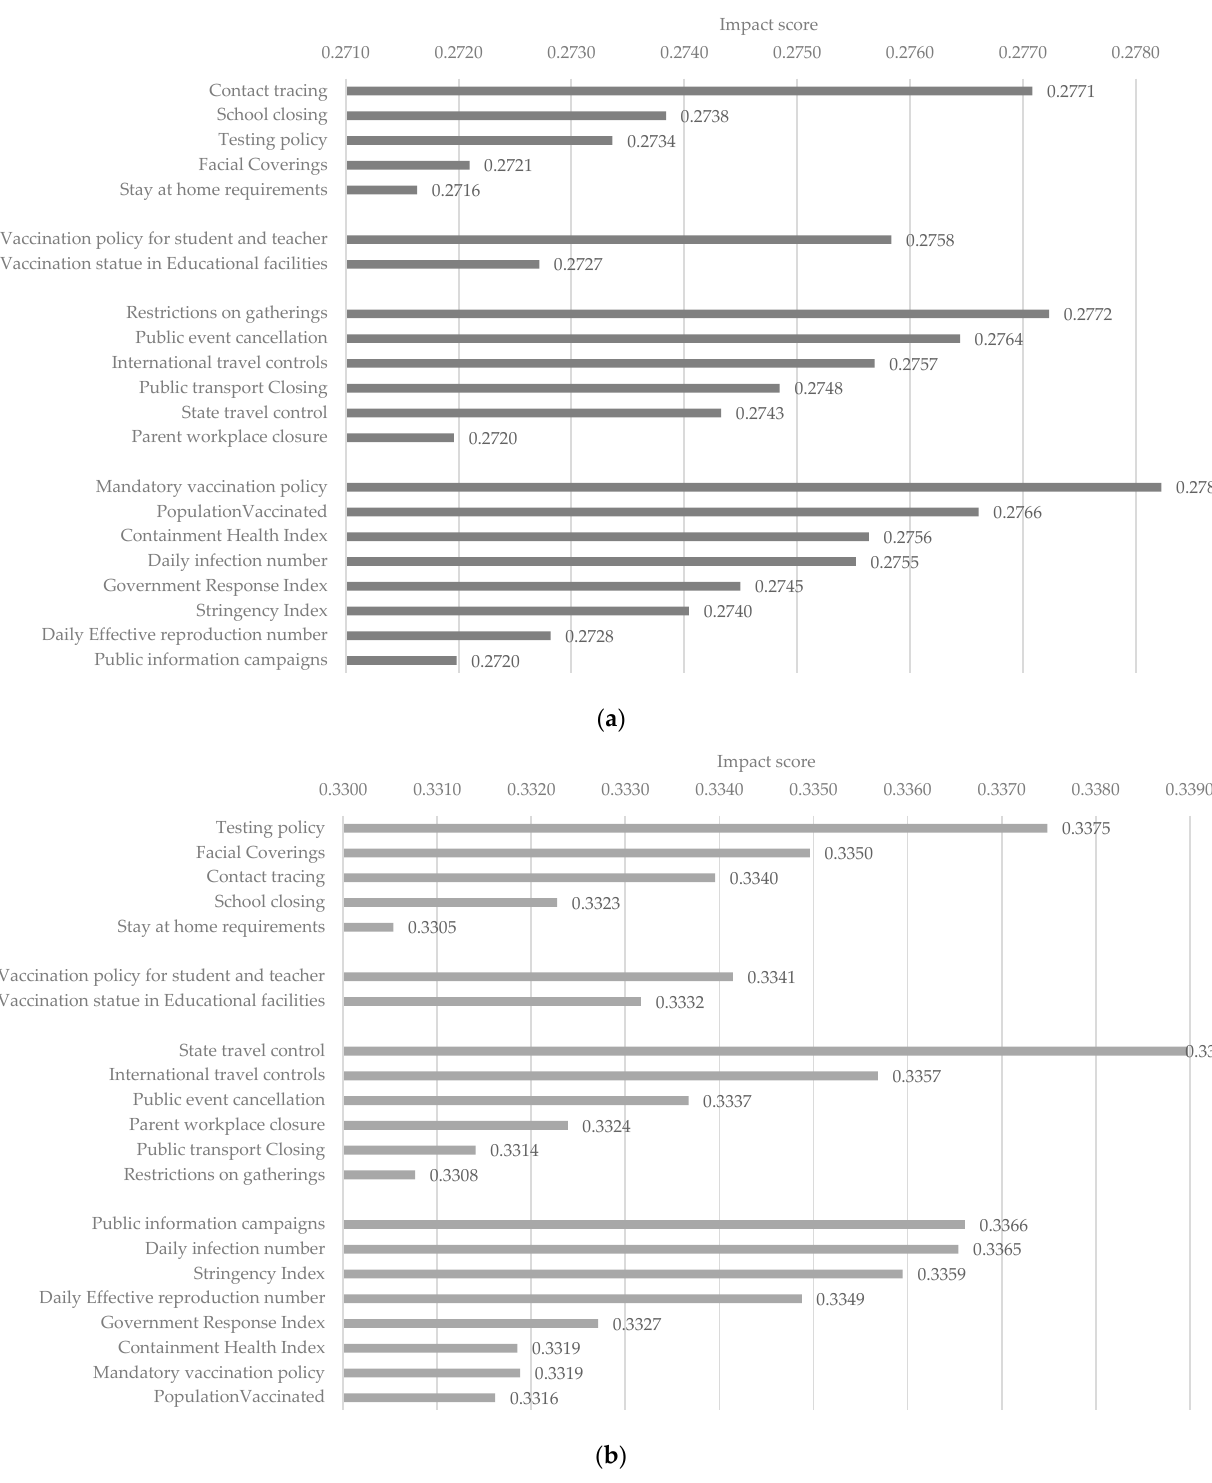
Figure 7. ( a ) Impact score for age group 0–9. ( b ) Impact score for age group 10–19. The impact score is calculated using the proposed comprehensive impact score review method based on the RNN-GRU model to decide the effectiveness of risk factors in preventing COVID-19 infection. The risk factors are listed in descending order within each risk dimension. The school-related risk factors (prevention strategies, immunisation status for the education sector) are listed first, followed by student-related community risk factors, and general population risk factors.